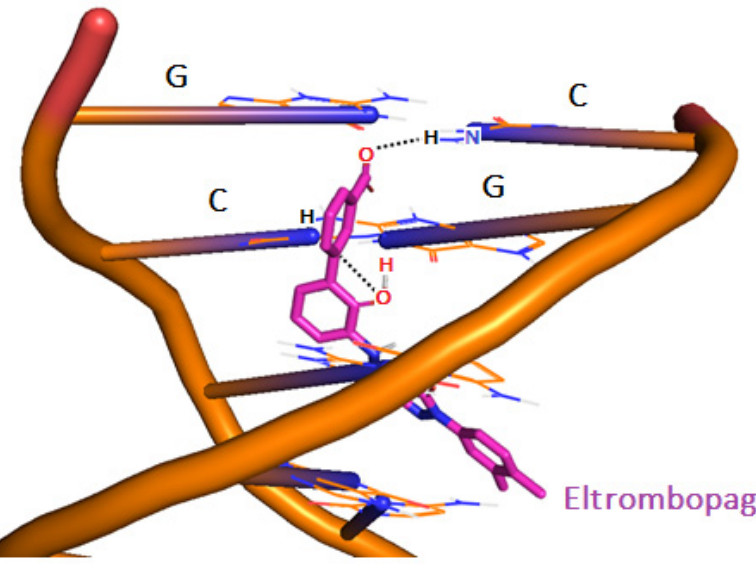
Figure 12. 3-D structure of ELT bound to 1BNA via intercalation mechanism at pH 7.4.